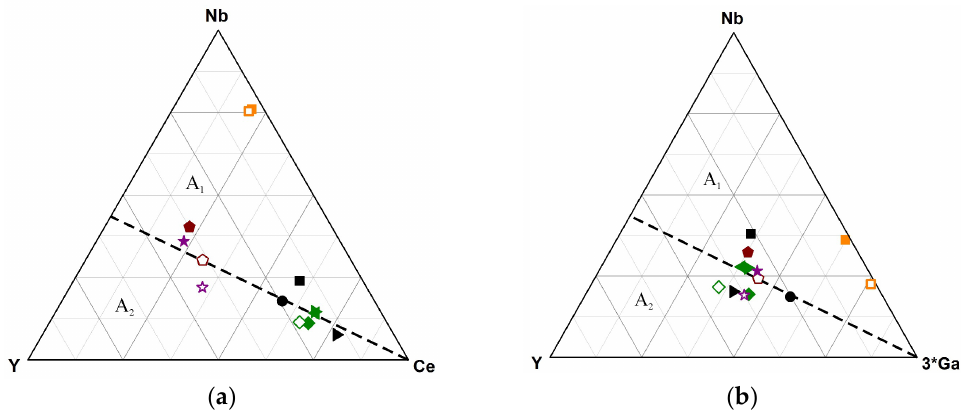
Figure 12. A 1 -A 2 type discrimination diagrams for A-type granitoids, according to [58]. ( a ) Y-Nb-Ce, ( b ) Y-Nb-3 Ga. The legend is the same as that presented in Figure 9.